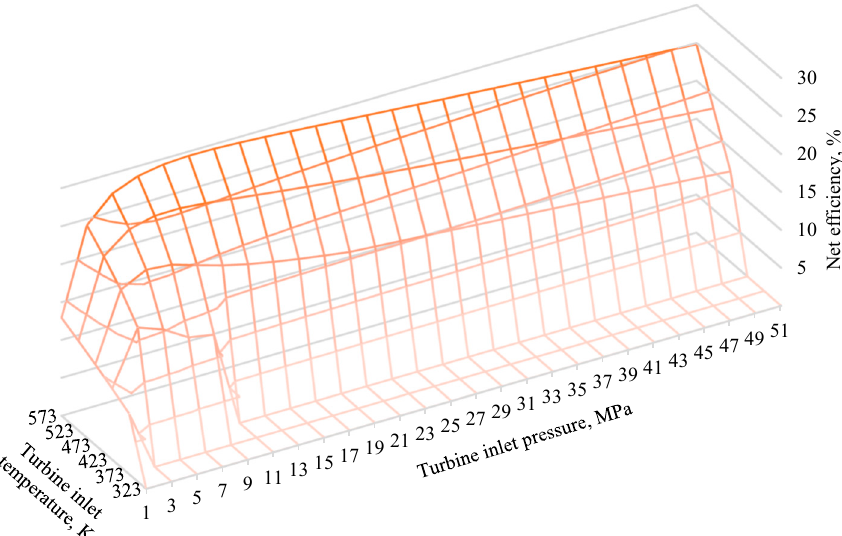
Figure 14. Net efficiency of Rankine cycle with regenerator for R124 and different inlet temperatures and pressures.